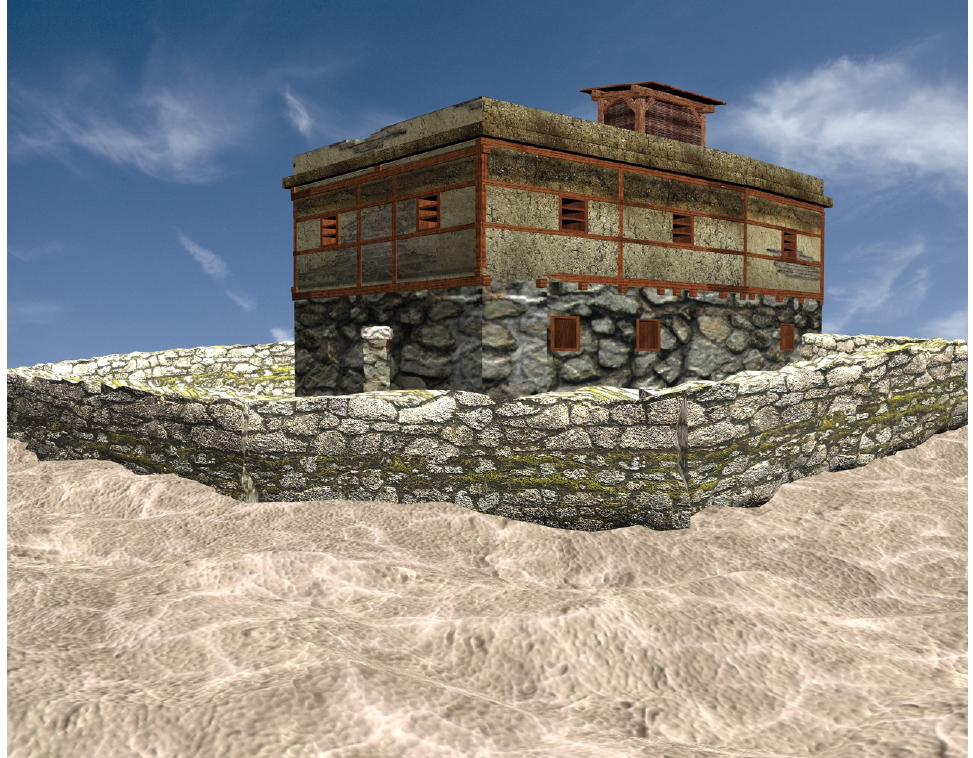
Figure 4. 3D reconstruction of Building I (closed/walled variety), set into the software-modified terrain, view from the southeast. Low walls are more or less conjectural. Created in Cinema